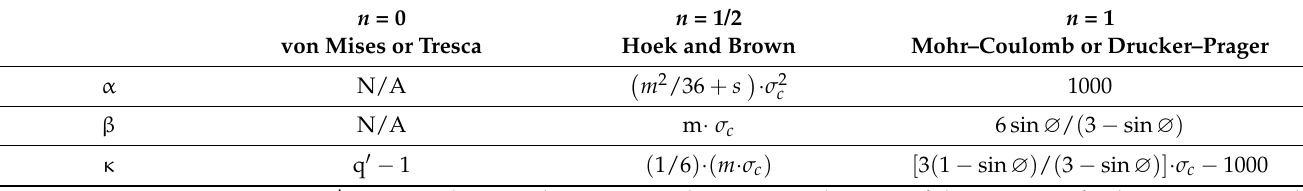
Table 2. Material constants in the Generalized Hoek and Brown